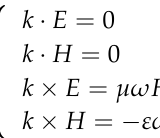
12 and the k 23